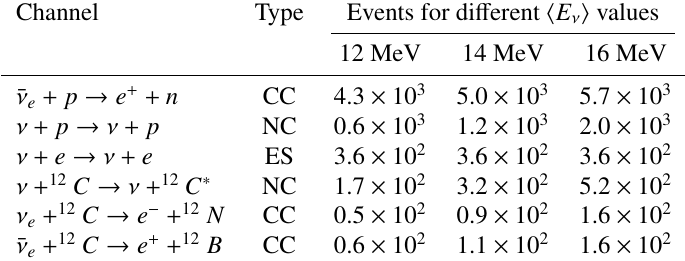
Table 1. Numbers of neutrino events in JUNO for a SN at a typical distance of 10 kpc. Three representative values of the average neutrino energy (cid:104) E ν (cid:105) = 12, 14 and 16 MeV are taken for illustration. For the elastic neutrino-proton scattering a threshold of 0.2 MeV for the proton recoil energy is considered. Channel Type Events for di ff erent (cid:104) E ν (cid:105) values 12 MeV 14